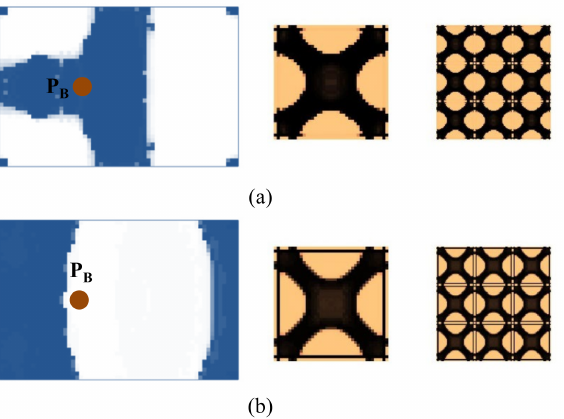
Figure 24. Design results obtained at excitation position P B and different excitation frequency